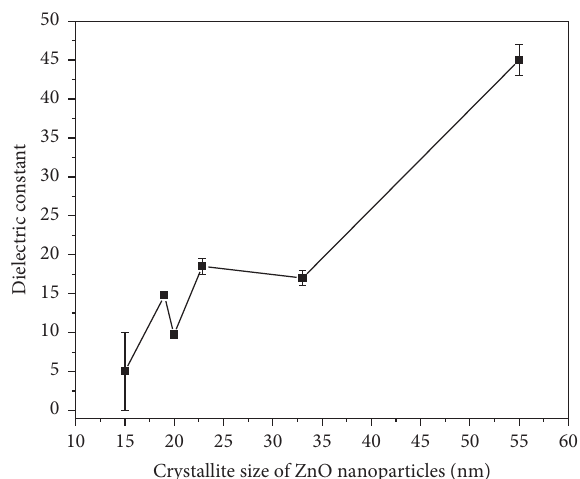
Figure 4: Variation of the dielectric constant of ZnO nanoparticles with respect to the crystallite size of ZnO